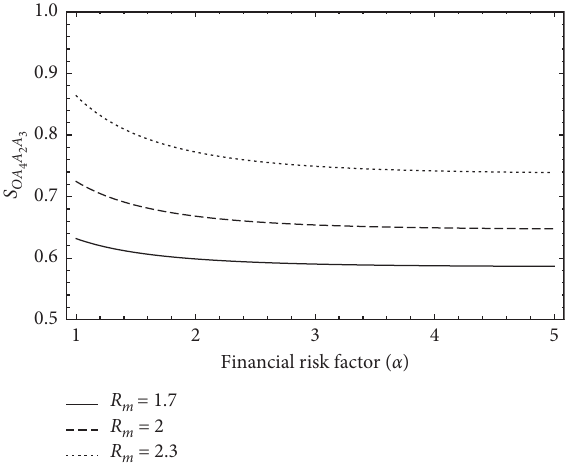
Figure 4: The impacts of financial risk factor on S various manufacturers’